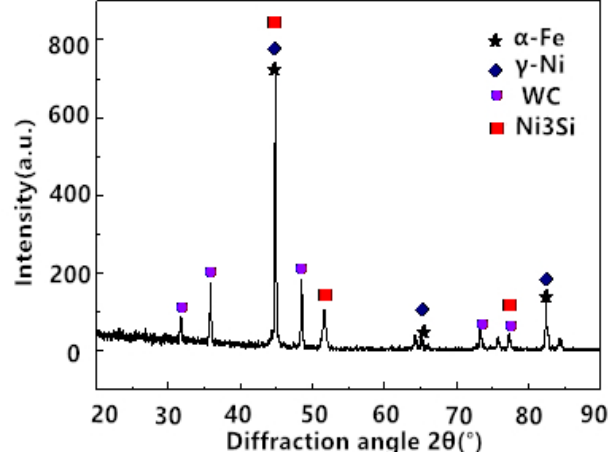
Figure 9. Cross-sectional XRD of the 1055 ◦ C composite Figure 9. Cross ‐ sectional XRD of the 1055 °C composite coating. Figure 9. Cross ‐ sectional XRD of the 1055 °C composite coating.